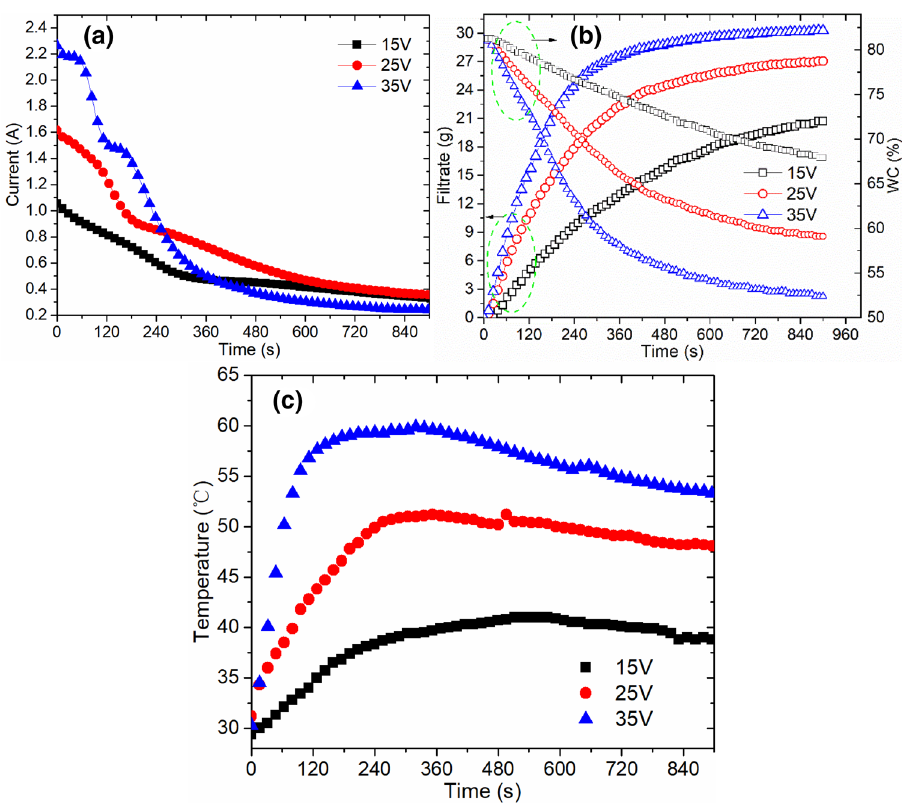
Figure 2. ( a ) Current, ( b ) filtrate, and ( c ) temperature variation in different voltage electro-dewatering process.